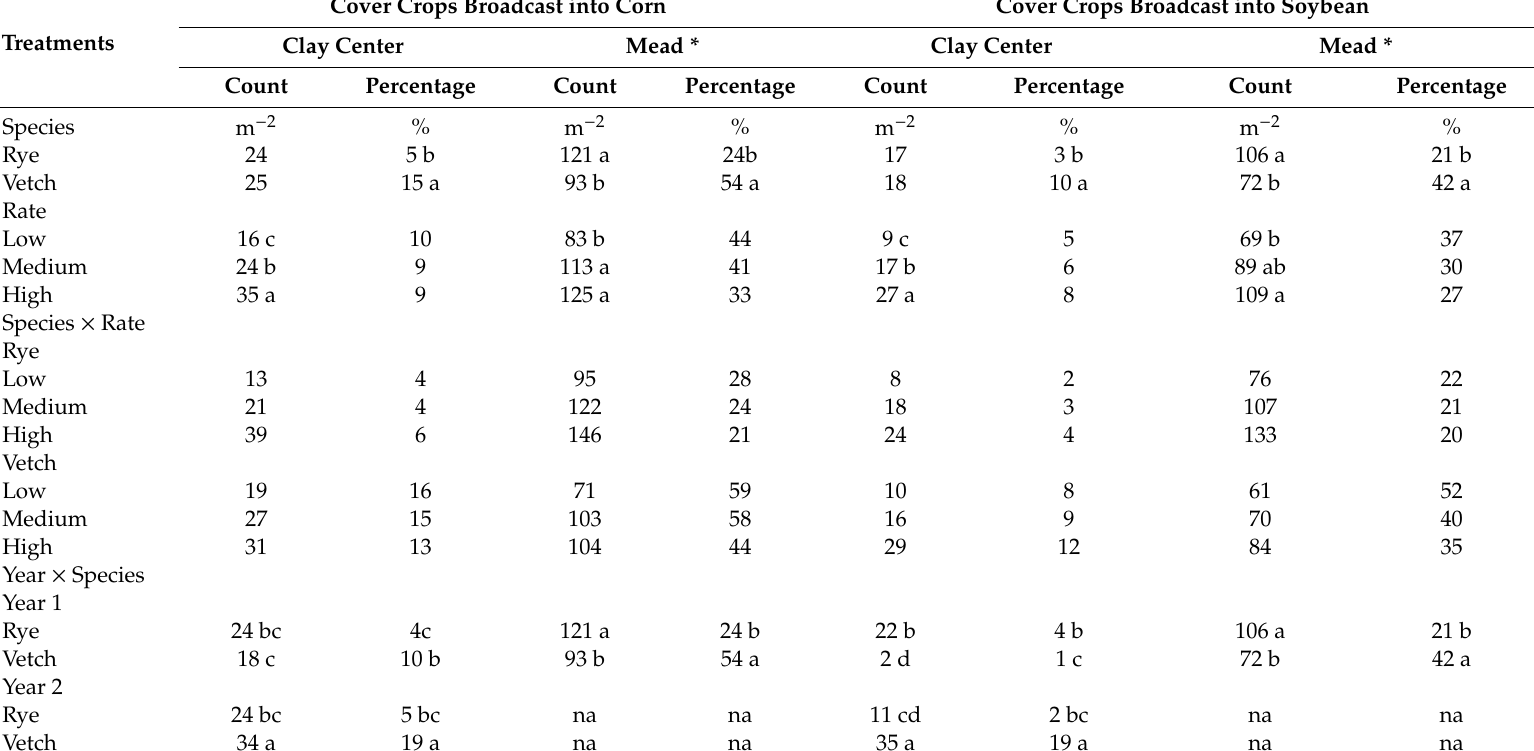
Table 4. The percentage of seed planted that emerged and the resulting stand counts (in plants m-2) for cereal rye (rye) and hairy vetch (vetch) cover crops, planted into corn and soybean at two sites (Clay Center and Mead). Within a column, means followed by the same letter are not significantly di ff erent from each other at a significance level of α =